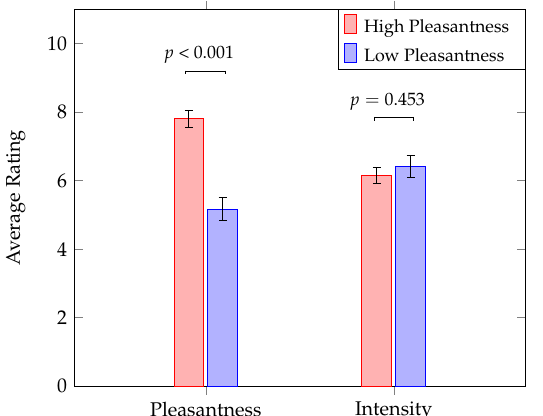
Figure 3. Paired-samples t -tests on behavioral response data reveal significant differences between high and low pleasantness stimuli; no meaningful discrepancies in fragrance intensity were observed. FDR corrected p -values are depicted; error bars show the standard error.